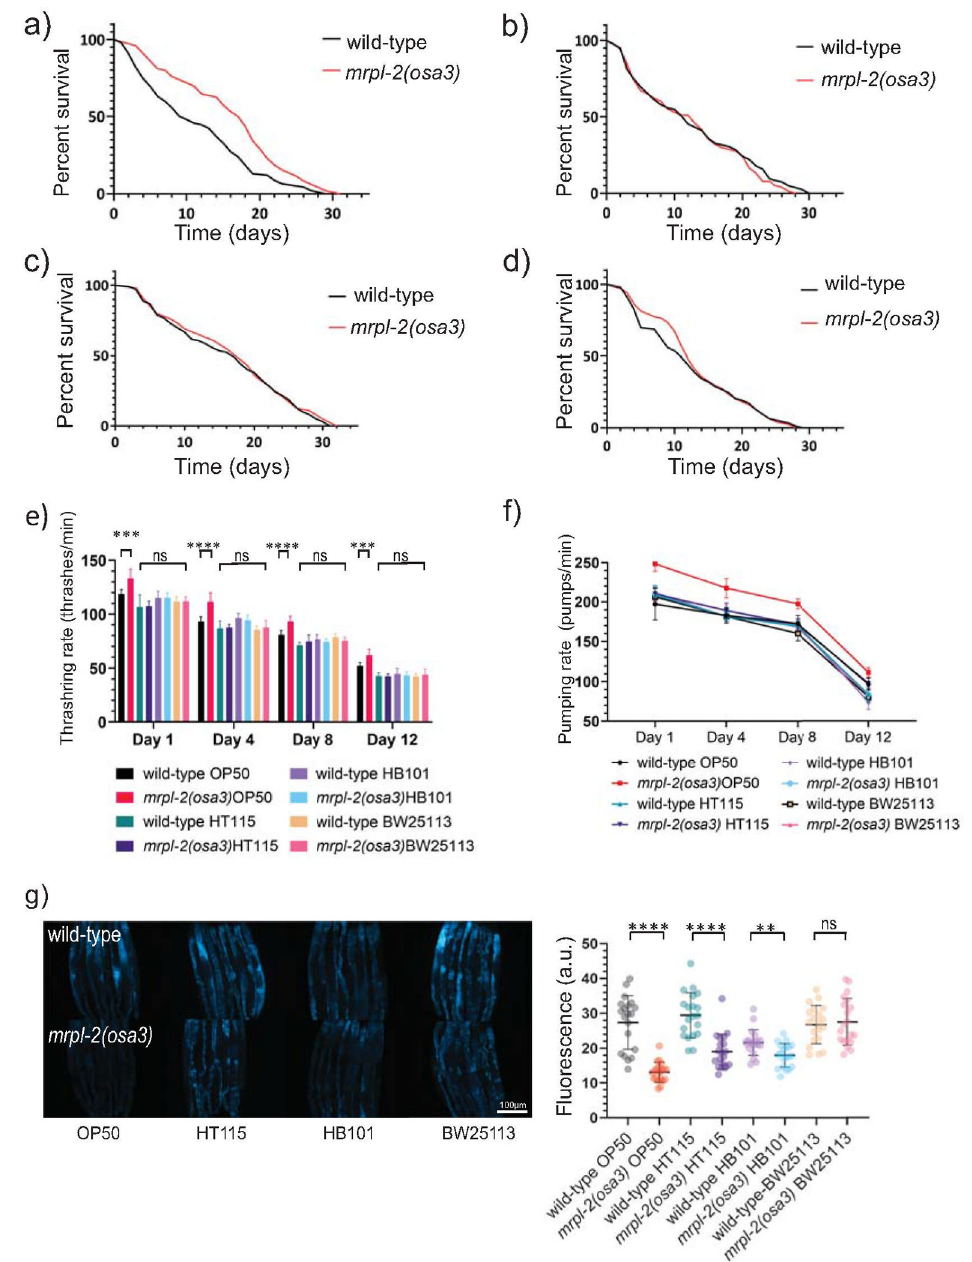
Fig 3. Diet-type determines lifespan in mrpl-2(osa3) animals. (A-D) Lifespans of wild-type and mrpl-2(osa3) animals fed E . coli (A) OP50, (B) HT115, (C) HB101, and (D) BW25113. See S1 Table for all lifespan assay statistics. (E) Whole body thrashing rate quantification of wild-type and mrpl-2(osa3) animals fed E . coli OP50, HT115, HB101, and BW25113. (mean ± SD; n � 10 worms); ns denotes not significant, ��� denotes p � 0.001, ���� denotes p � 0.0001 (Student’s t test). (F) Pharyngeal pumping rate quantification of wild-type and mrpl-2(osa3) animals fed E . coli OP50, HT115, HB101, and BW25113 (mean ± SD; n � 10 worms). (G) Photomicrographs and quantification of gut autofluorescence in wild-type and mrpl-2(osa3) animals. Quantification of fluorescence intensities expressed as arbitrary units (A.U.); ns denotes not significant, �� denotes p � 0.01, ���� denotes p � 0.0001 (Student’s t